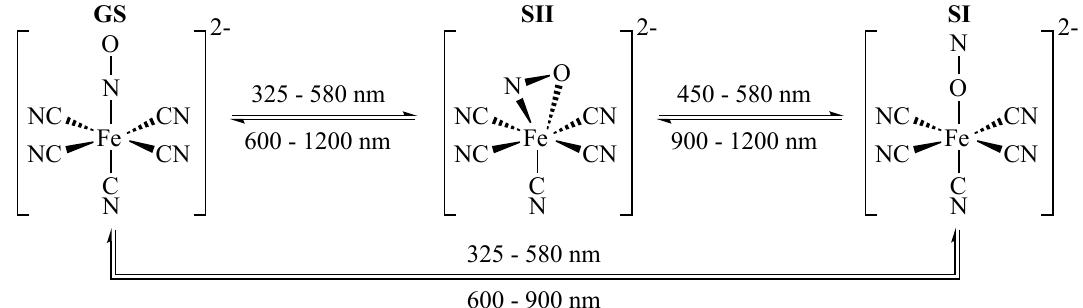
Figure 3. Nitroprusside ion in its three structural isomers. GS: thermally stable ground state; SI, SII: light-induced metastable states. The arrows indicate the light-induced isomerization pathways and the corresponding wavelengths for